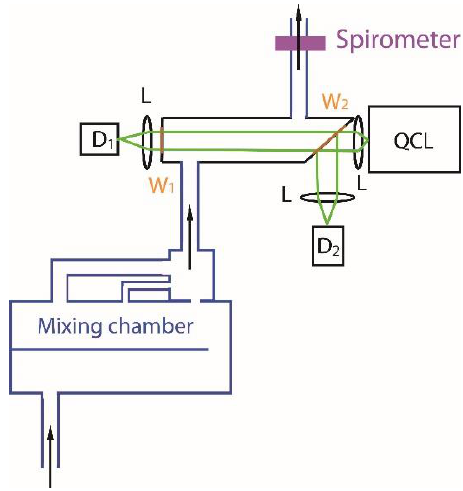
Figure 2. Schematic setup of a FLIP device with mixing chamber, sample chamber with sapphire windows, detectors D 1 and D 2 , quantum cascade laser (QCL), lenses L, and flow meter. The exhaled breath is pushed through the setup by respiration (see arrows). Note, the cross section of the whole setup is kept constant to ensure a laminar flow of the gas. The sample chamber, framed by the two sapphire windows W 1 and W 2 , has a length of 10 cm, and a cross sectional area of 5 cm 2 .